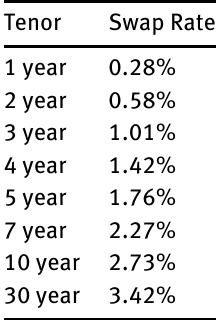
Table 4: The US swap rates at various tenors as of June 11,